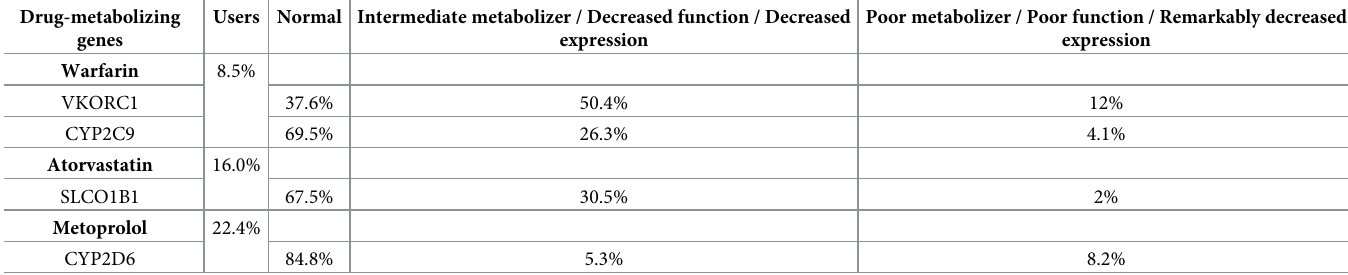
Table 3. Percentage of normal/intermediate/poor metabolizers, or persons with decreased or poor transporter function of SLCO1B1 or reduced expression of VKORC1, showing high proportions of potentially deviating drug responses to warfarin, atorvastatin and metoprolol. Drug-metabolizing Users Normal Intermediate metabolizer / Decreased function / Decreased genes